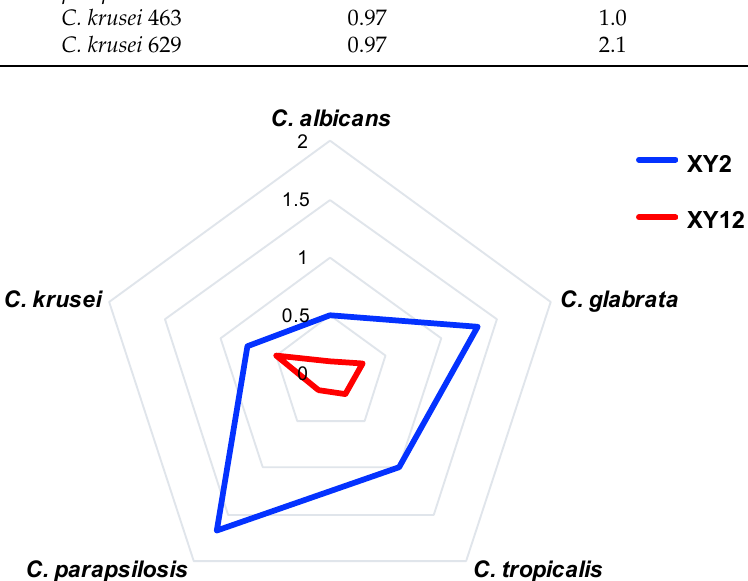
Figure 2. MICs of XY12 and XY2 against Candida species showed by Radar chart. To investigate the cytotoxicity of XY12 and XY2 , the viability of human umbilical vein endothelial cells (HUVECs) was assayed by CCK-8 agents. As shown in Figure 3, 7.8 µ M of XY12 showed almost no toxicity to HUVECs and the IC 50 of XY12 was about 34.6 µ M. However, a significant inhibitory effect of XY2 was observed at the concentration of 0.51 µ M. Meanwhile, the IC 50 of XY2 was about 1.8 µ M, which indicated that the cytotoxicity of XY12 was reduced by about 20-fold. Therefore, structural modification of XY2 at the terminal groups not only improves the antifungal activity, but also reduces the